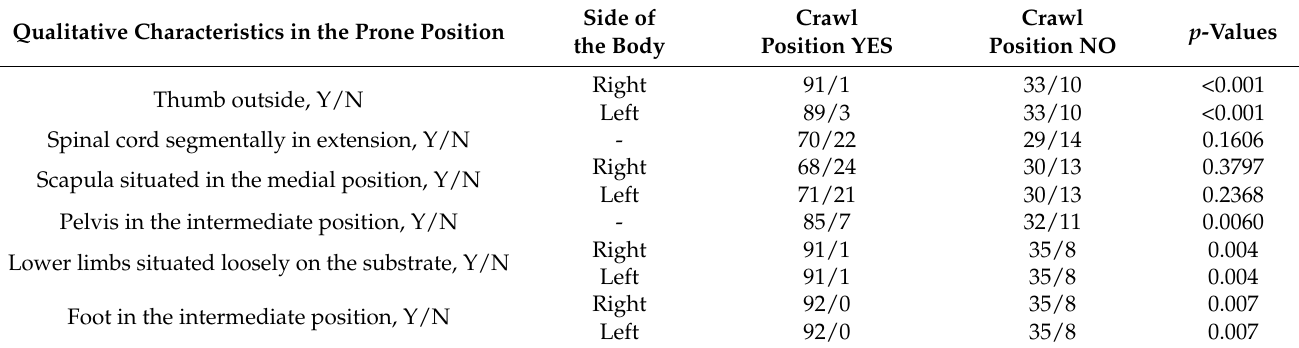
Table 3. The difference between children who achieved ( n = 92) or not ( n = 43) in the crawl position in the 7th month in